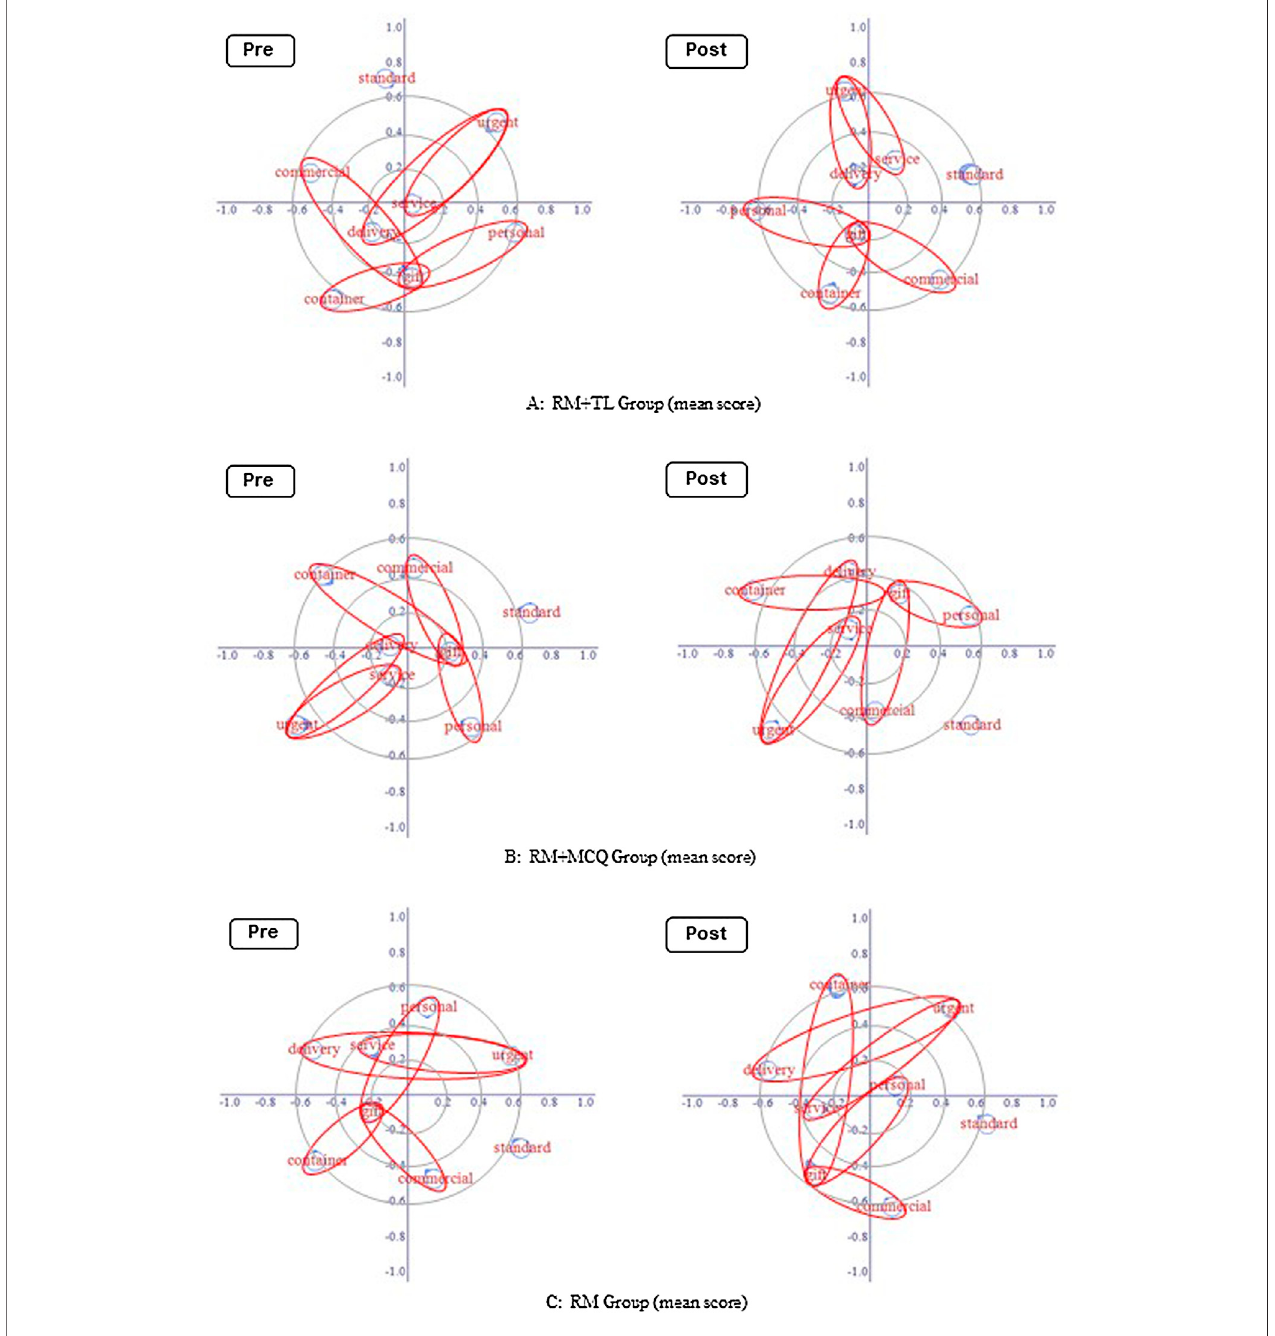
FIGURE 3 | AMISESCAL mapping of each group before (Pre) and after (Post) the